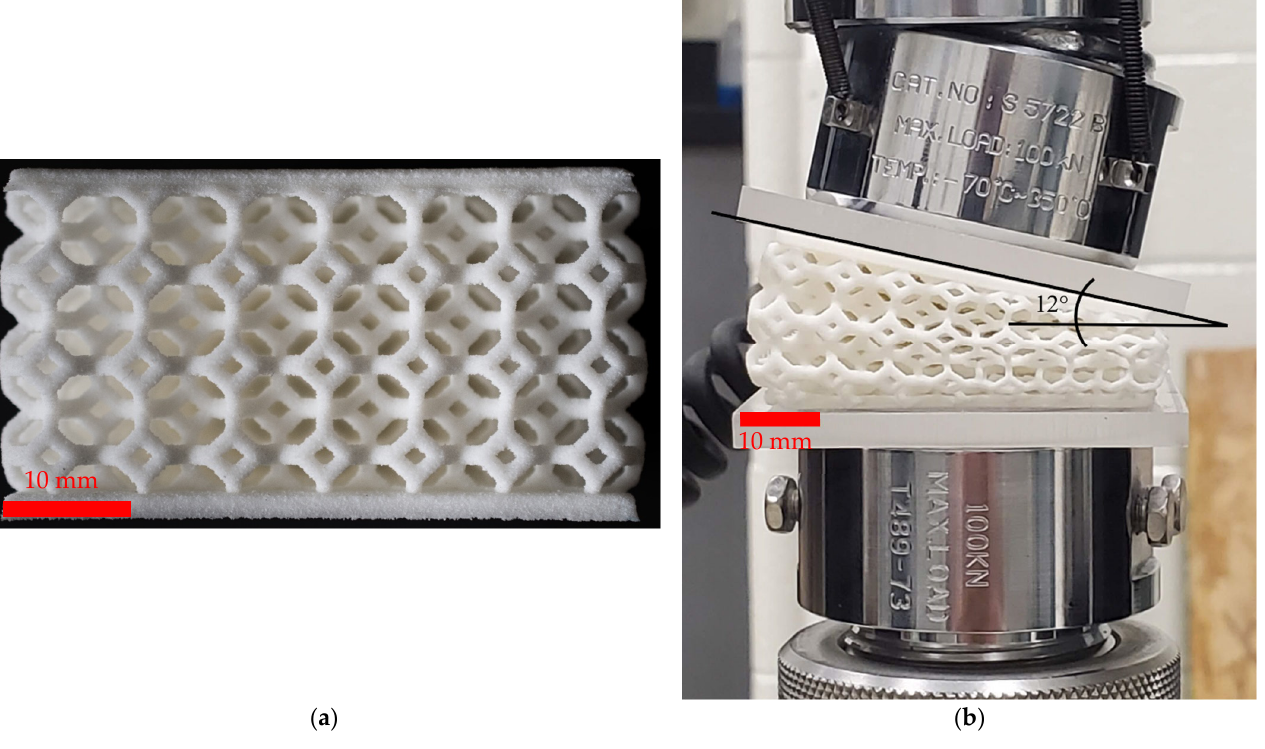
Figure 1. Printed Kelvin lattices: ( a ) non-graded as-built and ( b ) side-graded under quasi-static